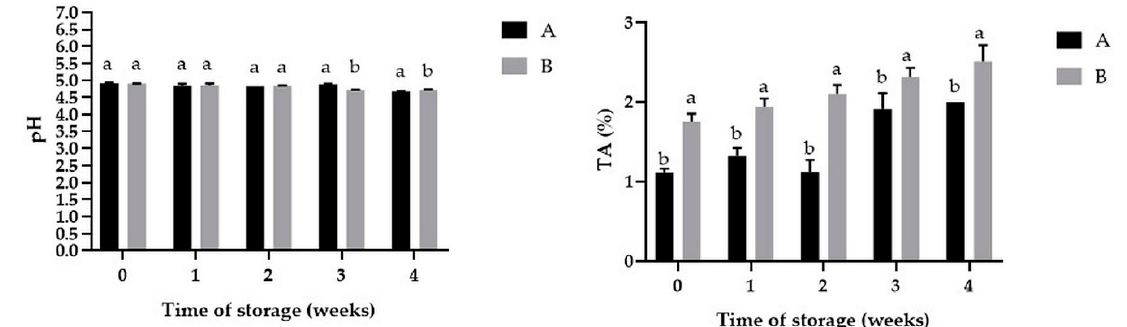
Figure 1. Changes of pH and TA during the storage in powders with 10% (A) and 20% (B) content of FO. Means with different lowercase letters are significantly different at p < 0.05.